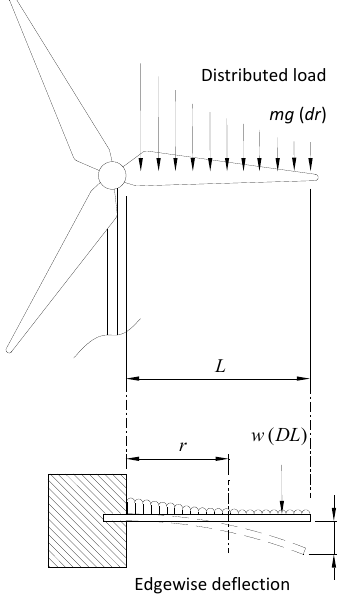
Figure 12. Gravitational load modelled as a cantilever